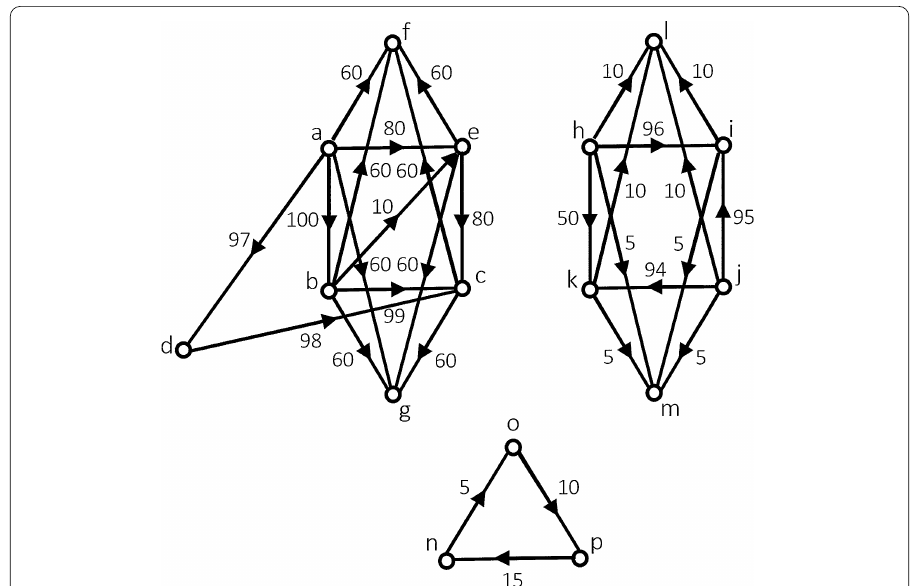
Figure 6 Another toy example. A toy example of a weighted directed